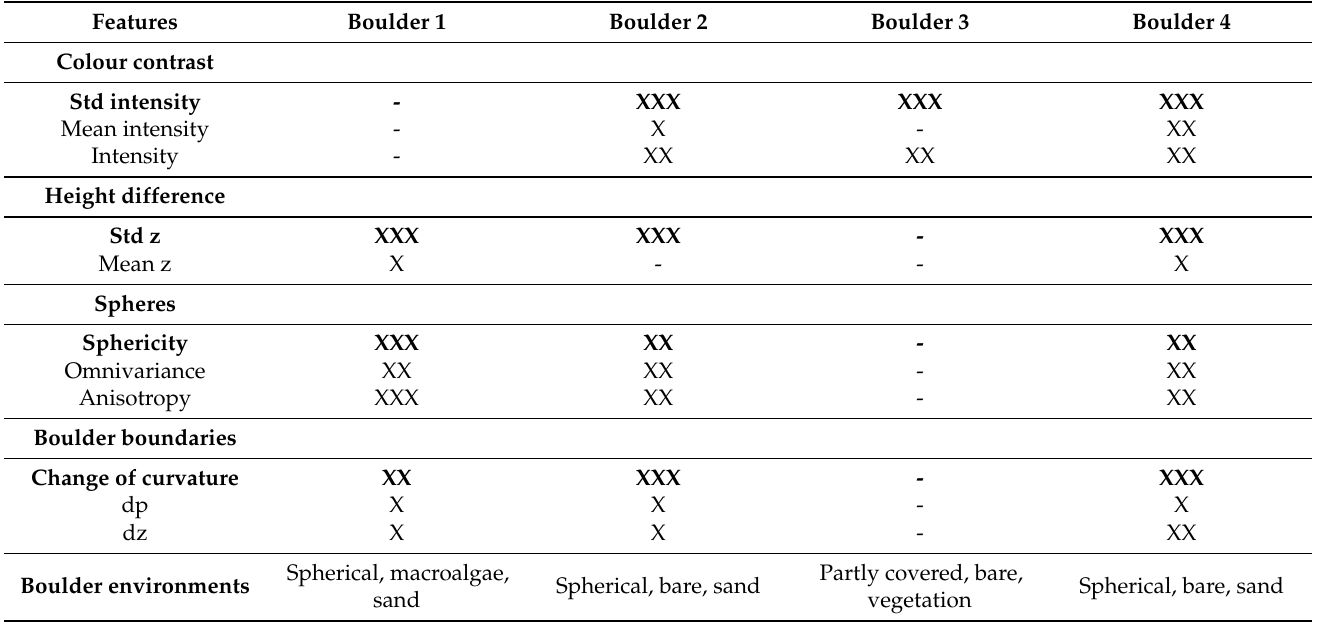
Table 9. Boulders represented in predictors. XXX means very clearly represented, XX means clearly represented, X means represented, - means not